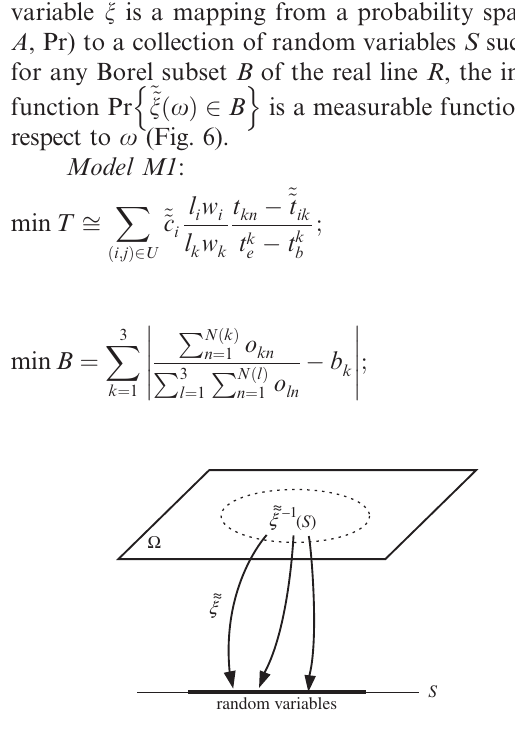
Fig. 5. An example of a ship’s arrangement in a lock